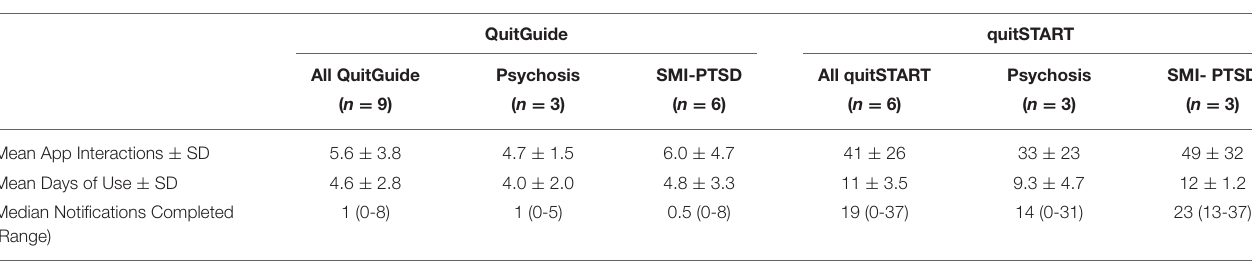
TABLE 3 | Summary of home app use measures over the two-week trial period. QuitGuide quitSTART All QuitGuide